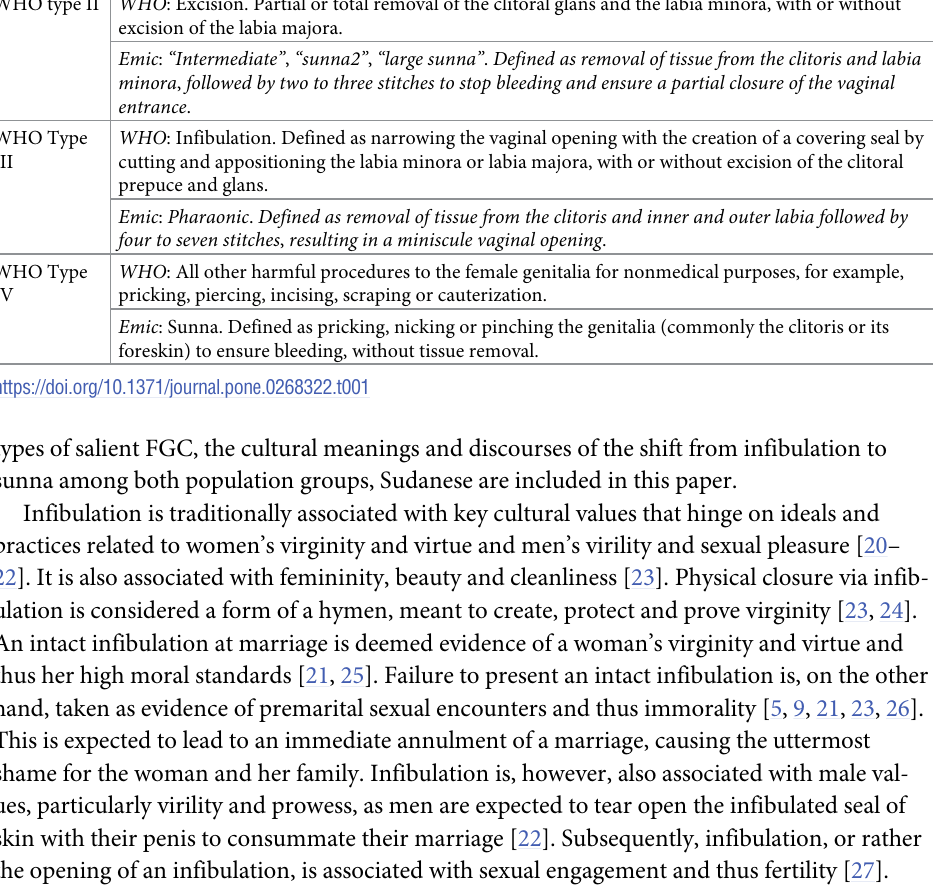
Table 1. WHO classifications, juxtaposed with emic typology and terminology from Somalia and Sudan. WHO Type I WHO : Clitoridectomy. Defined as complete or partial removal of the (external part of) clitoris. Emic : Sunna circumcision, small circumcision. Defined as removal of the tip of the clitoral glans. WHO type II WHO : Excision. Partial or total removal of the clitoral glans and the labia minora, with or without excision of the labia majora. Emic : “Intermediate” , “sunna2” , “large sunna” . Defined as removal of tissue from the clitoris and labia minora , followed by two to three stitches to stop bleeding and ensure a partial closure of the vaginal entrance . WHO Type WHO : Infibulation. Defined as narrowing the vaginal opening with the creation of a covering seal by III cutting and appositioning the labia minora or labia majora, with or without excision of the clitoral prepuce and glans. Emic : Pharaonic . Defined as removal of tissue from the clitoris and inner and outer labia followed by four to seven stitches , resulting in a miniscule vaginal opening . WHO Type WHO : All other harmful procedures to the female genitalia for nonmedical purposes, for example, IV pricking, piercing, incising, scraping or cauterization. Emic : Sunna. Defined as pricking, nicking or pinching the genitalia (commonly the clitoris or its foreskin) to ensure bleeding, without tissue removal.